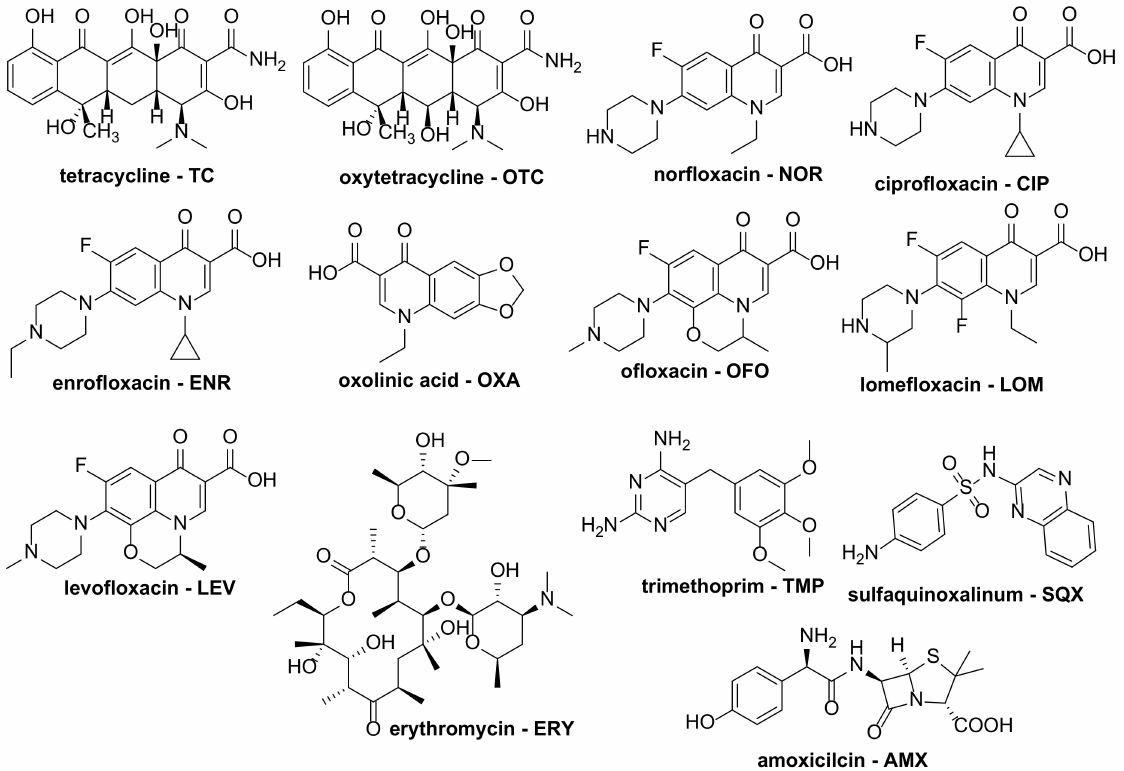
Figure 1. Structures of antibiotics tested in TPM-catalyzed degradation in the last